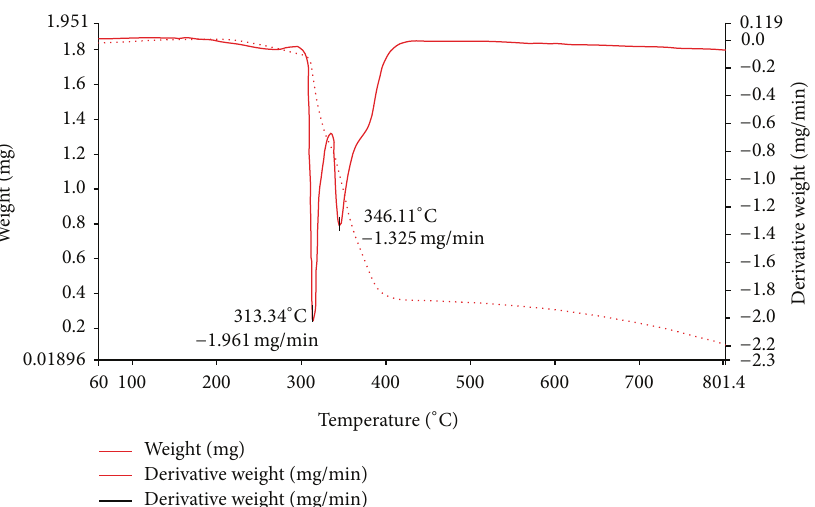
Figure 1: TG-DTA plot of Ni(II) complex.